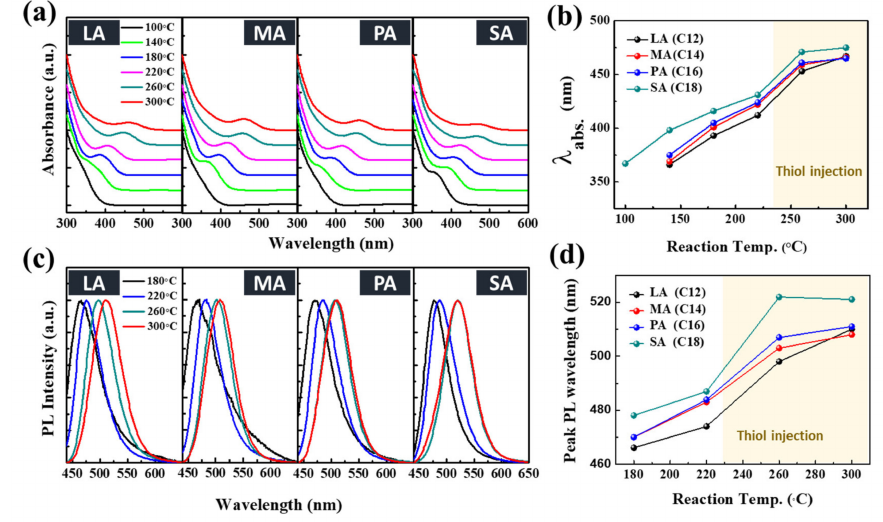
Figure 3. ( a ) Temporal evolution of UV–vis absorption spectra of InP / GaP / ZnS QDs with lauryl acid (LA), myristic acid (MA), palmitic acid (PA), and stearic acid (SA) as the capping ligands and ( b ) their first excitation transition wavelengths, which were determined from second derivatives of the spectra. ( c ) photoluminescence (PL) emission spectra and ( d ) the PL peak wavelength of the corresponding